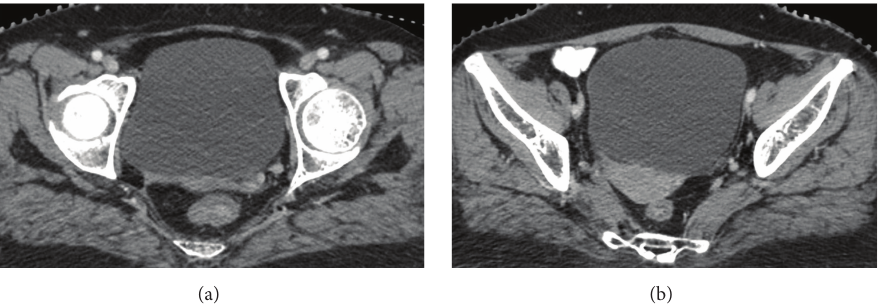
Figure 3: CT scan after six cycles of chemotherapy showing almost complete regression of the cervical mass and its extensions (a, b).